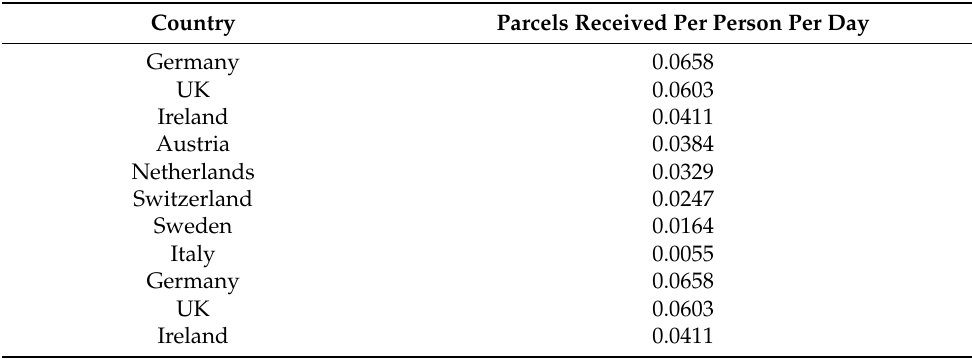
Table 1. Average B2C e-commerce parcels received per person per day.